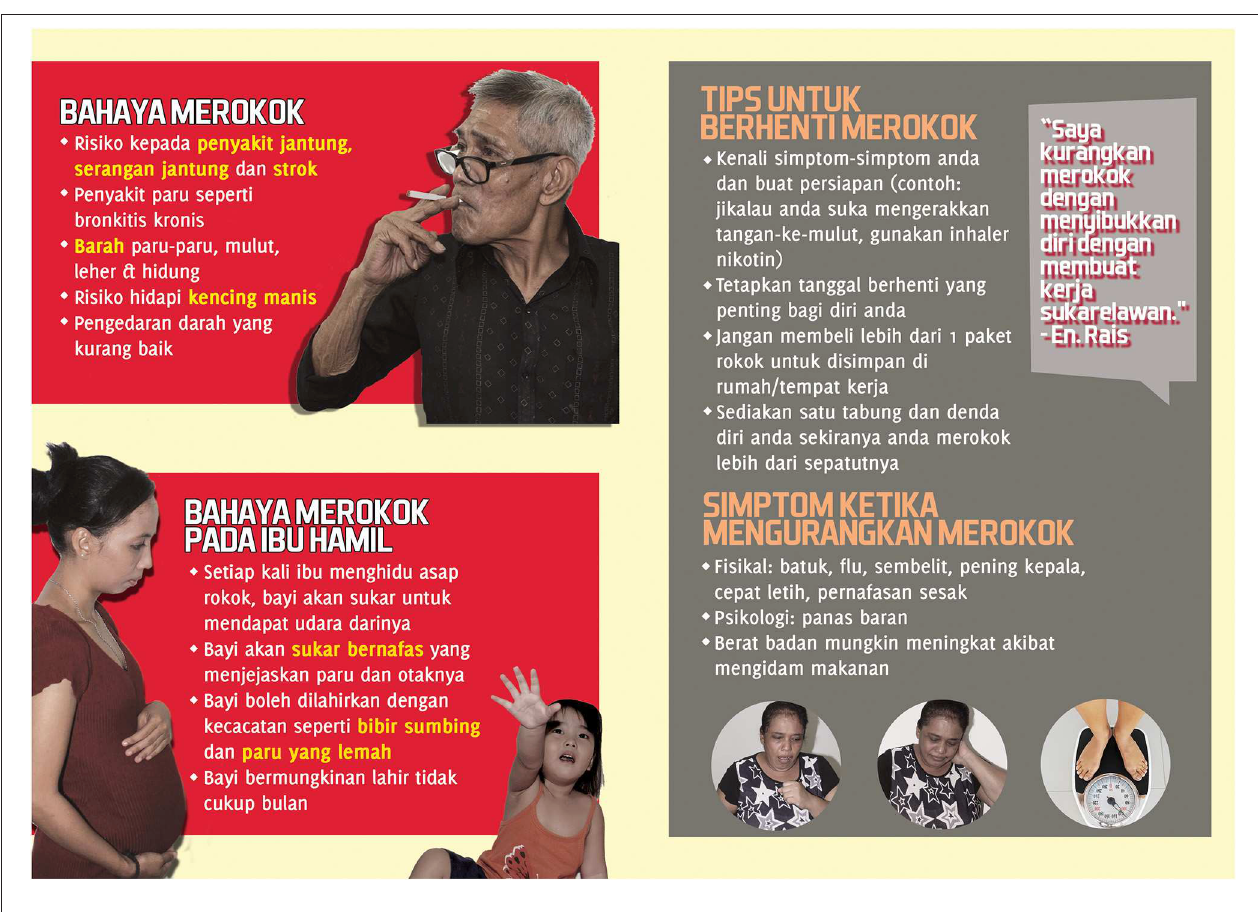
FIGURE 4 | Information about Smoking Cessation.